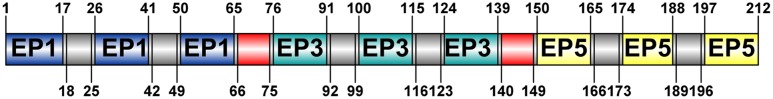
rqTSA-25 amino acid sequence.Predicted amino acid sequences of rqTSA-25, showing the flexible linker in gray and hard linker in red.